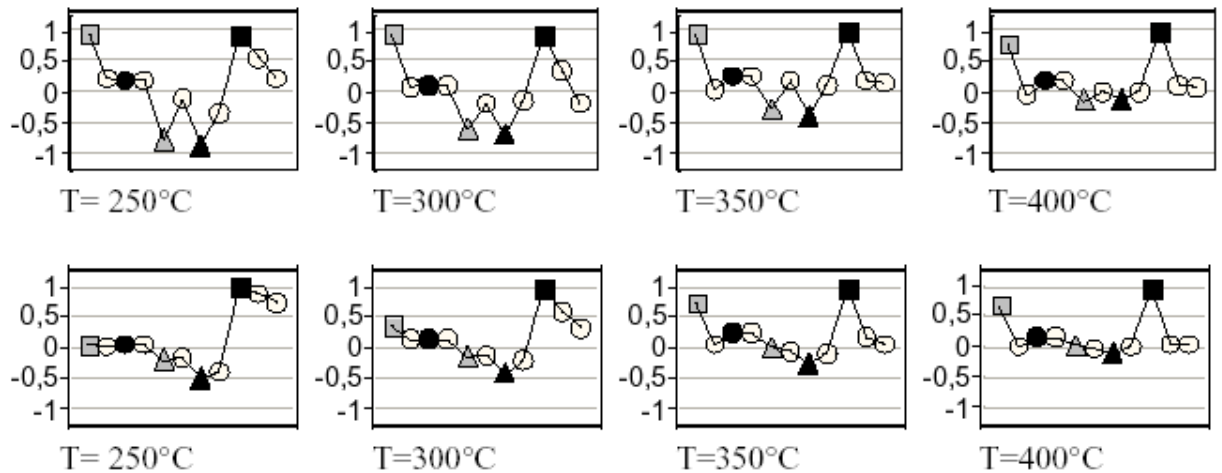
Ag O (above) 99,5 0,5 x , CO, NO, NO , 2 2